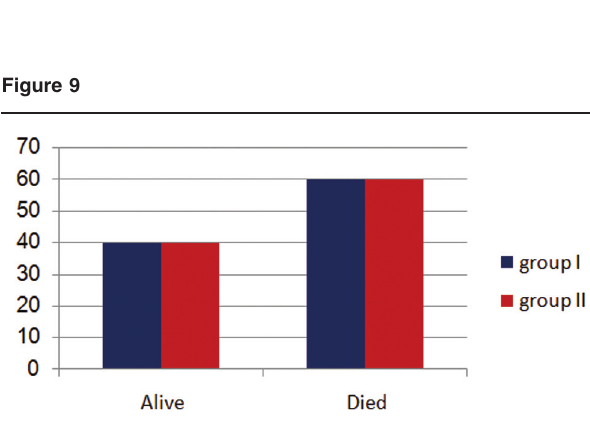
Comparison between groups as regards mortality.